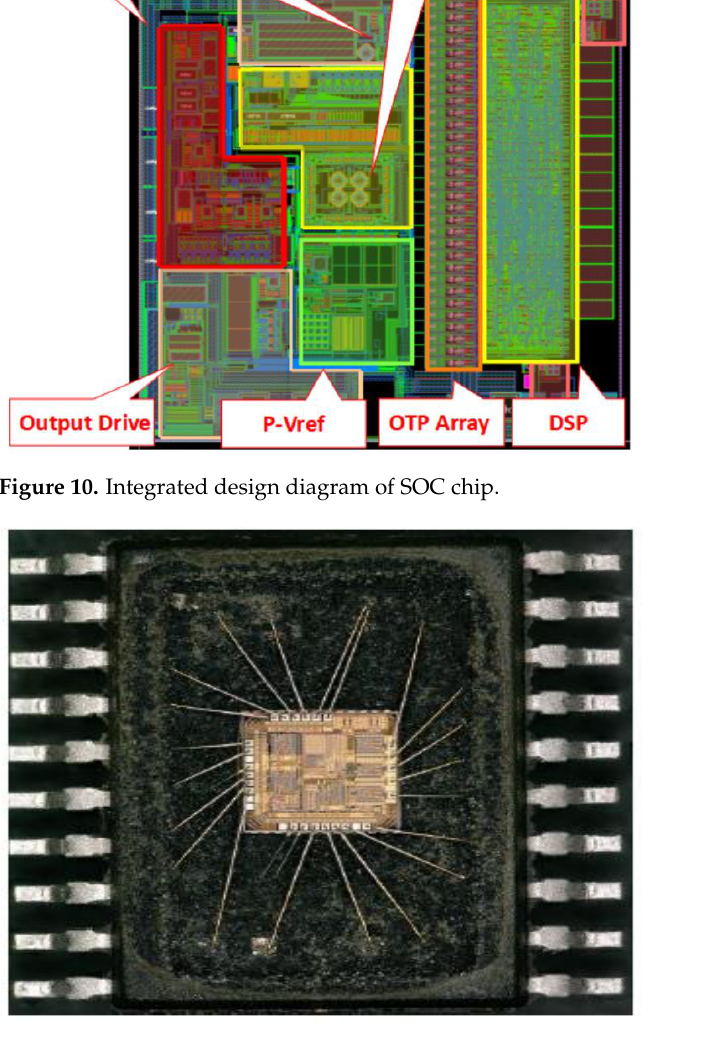
Figure 11. Perspective of the chip.